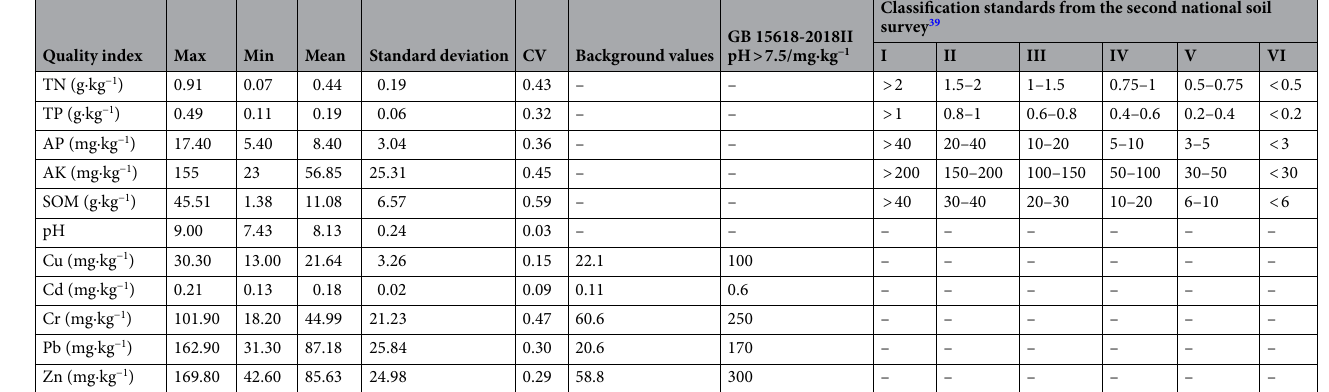
Table 2. Descriptive statistical characteristics of the soil quality indicators. Max maximum value, Min minimum value, CV coefficient of variation, TN total nitrogen, TP total phosphorus, AP available phosphorus, AK available potassium, SOM soil organic matter, Cu copper, Cd cadmium, Cr chromium, Pb lead, Zn zinc. The measured heavy metal data come from Xu et al. 30 . GB 15,618-2018II: "Soil Environmental Quality in Agricultural Land Soil Pollution Risk Control Standards", soil pollution risk screening value from the State Environmental Protection Administration of China (2018). Background value: CNEMC 35